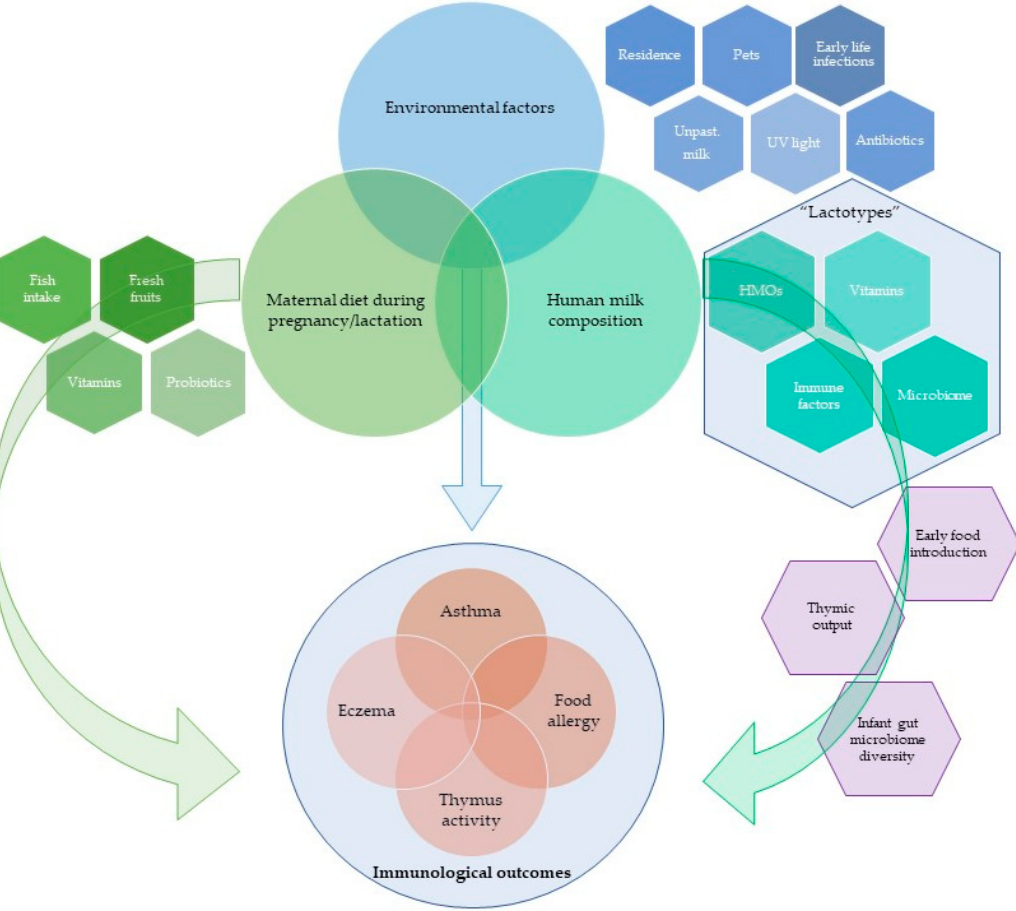
Figure 1. Maternal, environmental and human milk composition factors influence on immunological outcomes in child.